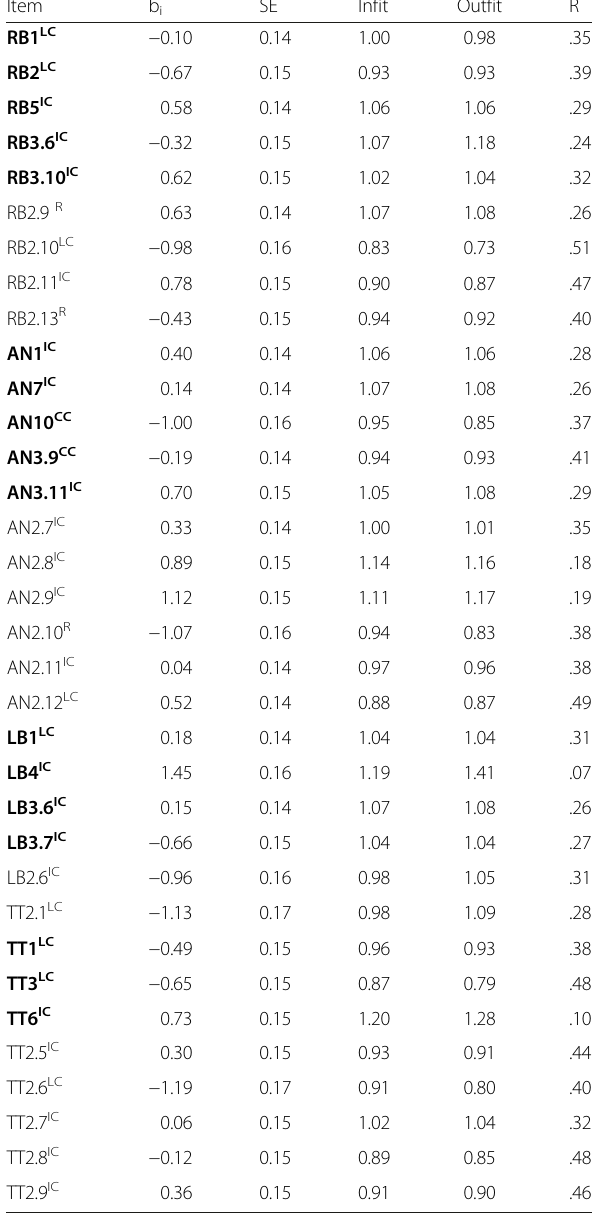
Table 2 Psychometric properties of the items of the